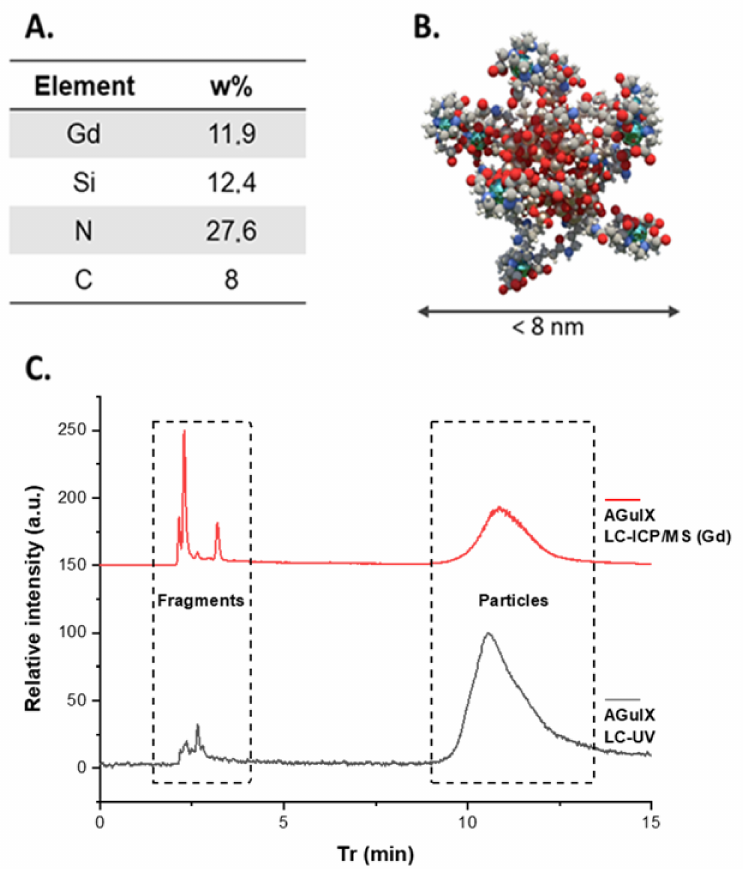
Figure 1. ( A ) Elemental analysis of AGuIX ( B ) Schematic representation of AGuIX NPs (gadolinium atoms in green are chelated in DOTAGA ligands grafted to polysiloxane matrix). ( C ) LC-ICP/MS chromatogram of AGuIX (5 µ L, 10 g/L) recorded at Gd 152 channel (red). LC-UV chromatogram of AGuIX (5 µ L, 10 g/L) recorded at λ = 295 nm